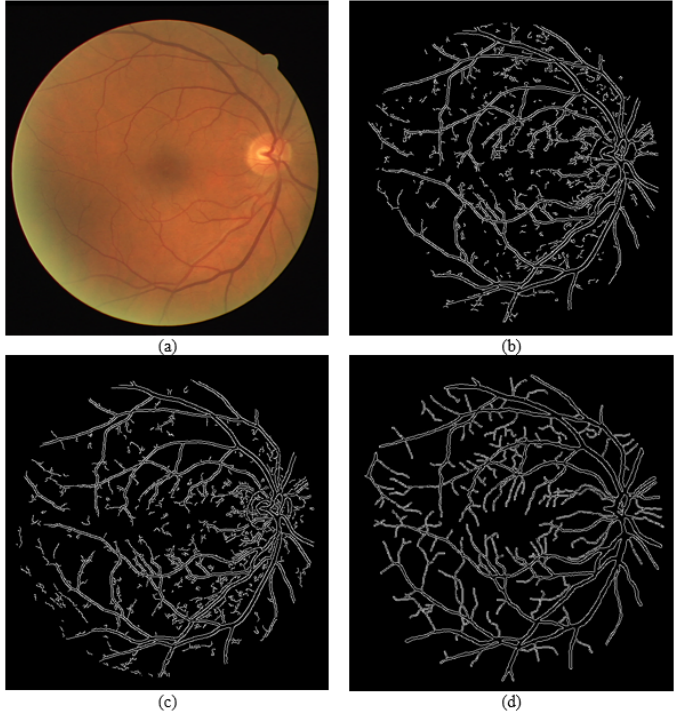
Figure 17. Comparison of segmented images for Photo 3 . ( a ) Input image. ( b ) Segmented image using the proposed approach (GUI based). ( c ) Segmented image using Canny detector with ideal parameters. ( d ) Ground truth image from DRIVE dataset.